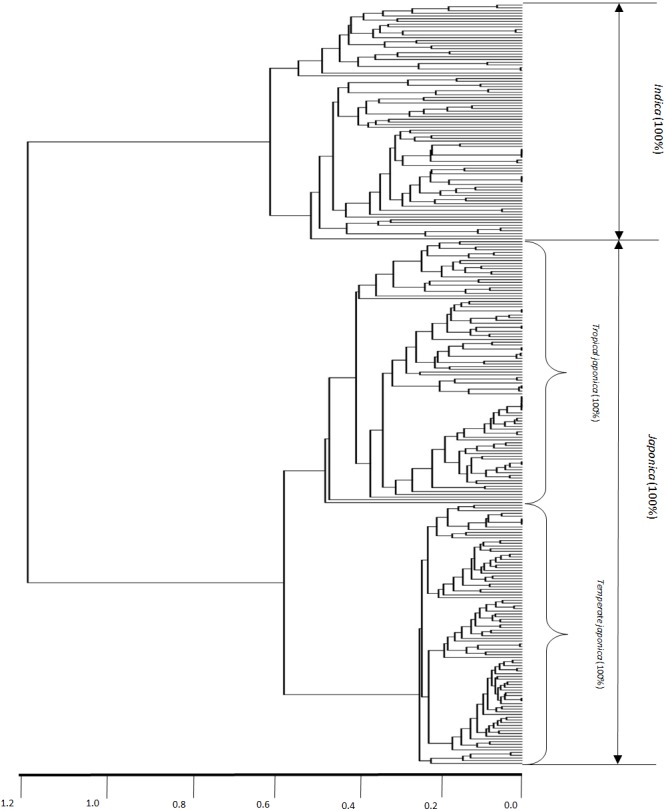
Dendrogram-based indica/japonica classification of 280 accessions, obtained by using 36,901 SNPs.